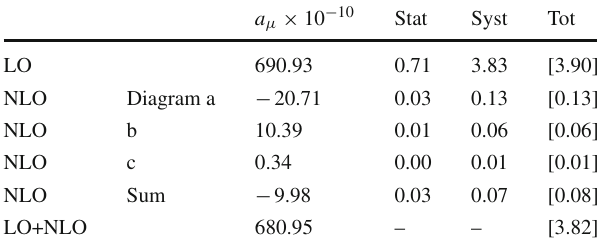
Table8 LO-andNLO-HVPresultsinthestandarddispersiveapproach based on e + e − data. The NLO diagrams are shown in Fig.